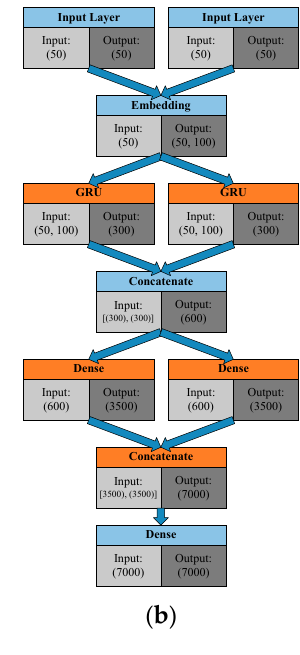
Figure 5. Architecture of the chatbot: ( a ) LSTM version; and ( b ) Enhanced GRU version. Table 1. Parameters setting of the chatbot.